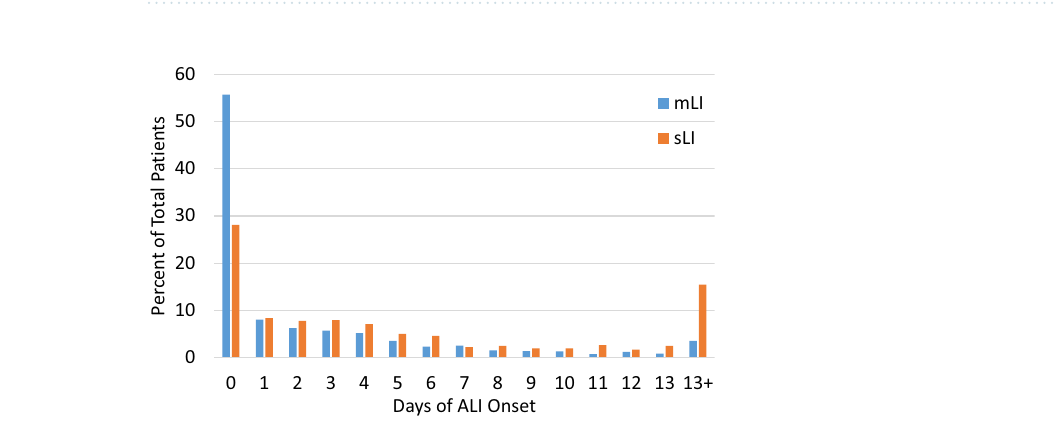
Table 1. Demographics, comorbidities, and laboratory variables at admission of nLI, mLI, and sLI groups. Group comparison of categorical variables in frequencies and percentages used Chi-squared test or Fisher exact tests. Group comparison of continuous variables in means and SEMs (standard error of means) used the Mann–Whitney U test. All values are in n (%) unless otherwise specified.